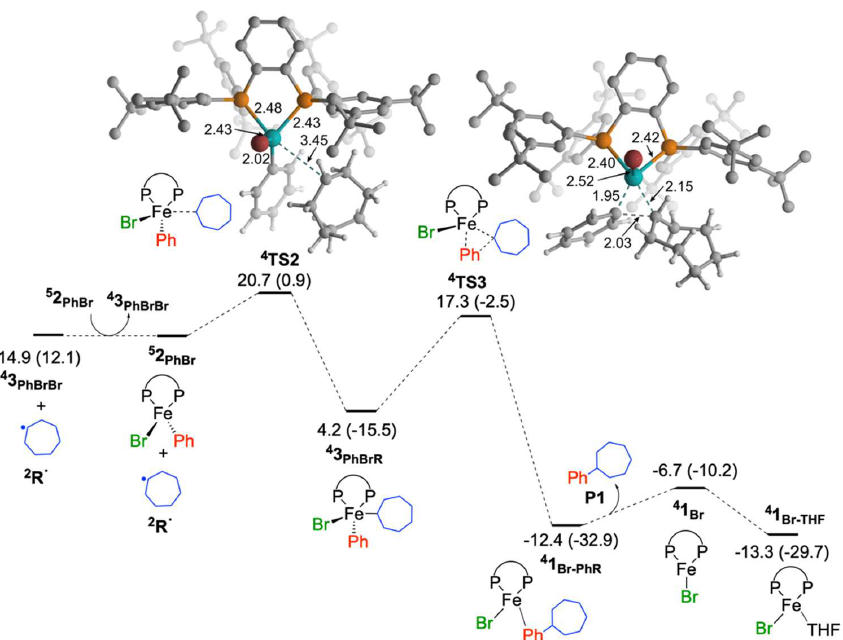
Figure 3. Free energy profile for cross-coupling by the reaction of iron(II) species with cycloheptyl radical, where radical is generated by the reaction of iron(II) species and bromocycloheptane. Free energies with respect to 5 2 PhBr and bromocycloheptane are given in kcal/mol (ΔE ZPE are given in